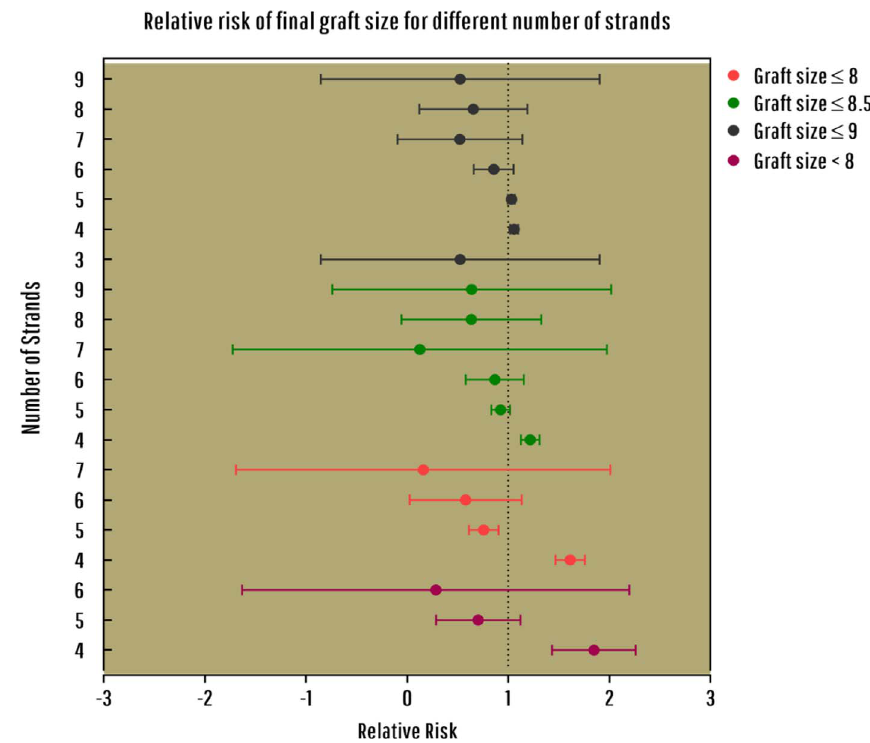
Figure 3. Relative risk (RR) of fi nal graft sizes for different number of strands.